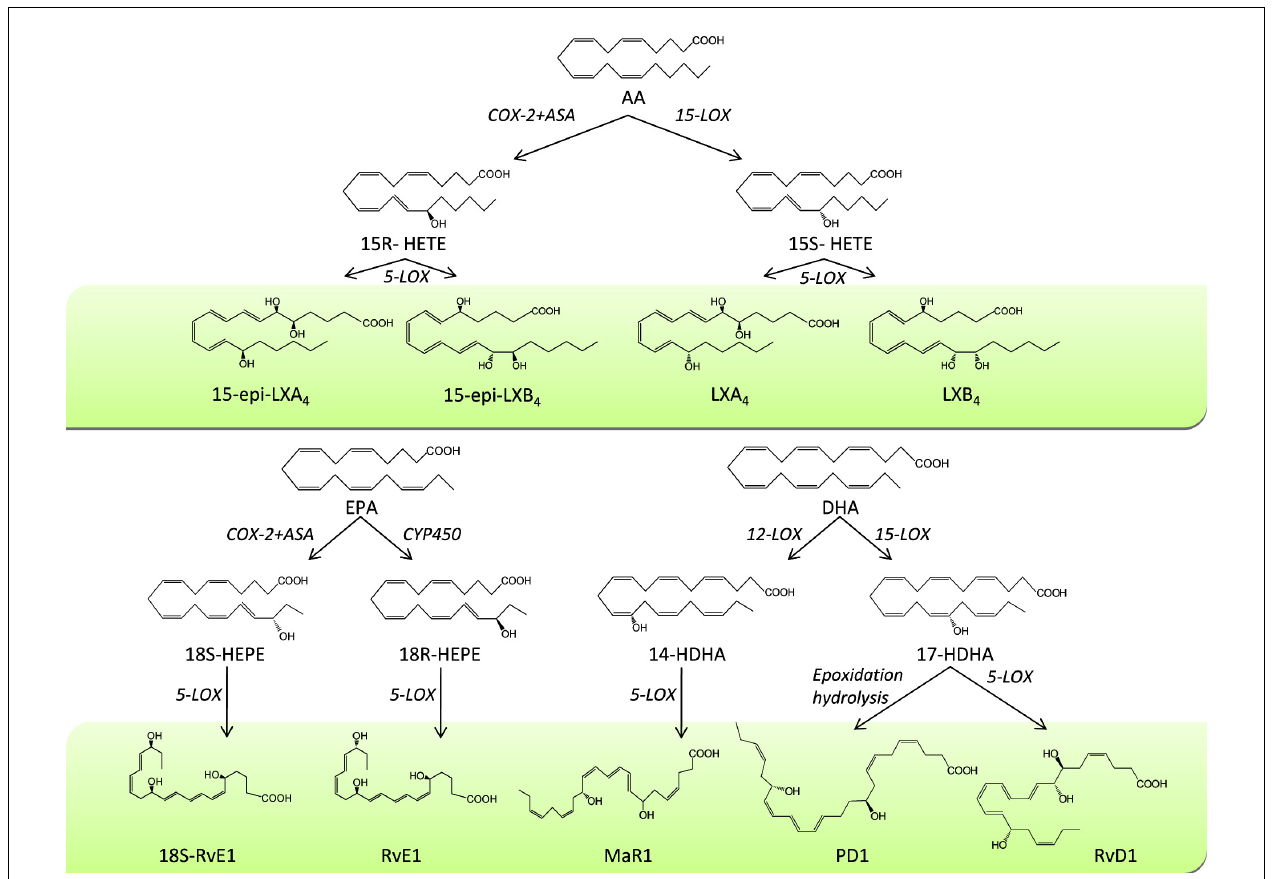
FIGURE 1 | Biosynthesis of specialized pro-resolving mediators (SPM). During the process of resolution of inflammation, the omega-6 fatty acid arachidonic acid (AA) is converted by 15-lipoxygenase (15-LOX) to 15 S -hydroxyeicosatetraenoic acid (15 S -HETE), which is rapidly converted to LXA 4 and LXB 4 by 5-LOX. Formation of 15-epi-LXA 4 and 15-epi-LXB 4 from 15 R -HETE can also occur after acetylation of cyclooxygenase-2 (COX-2) by aspirin (ASA). Similarly, the omega-3 fatty acid eicosapentaenoic acid (EPA) is